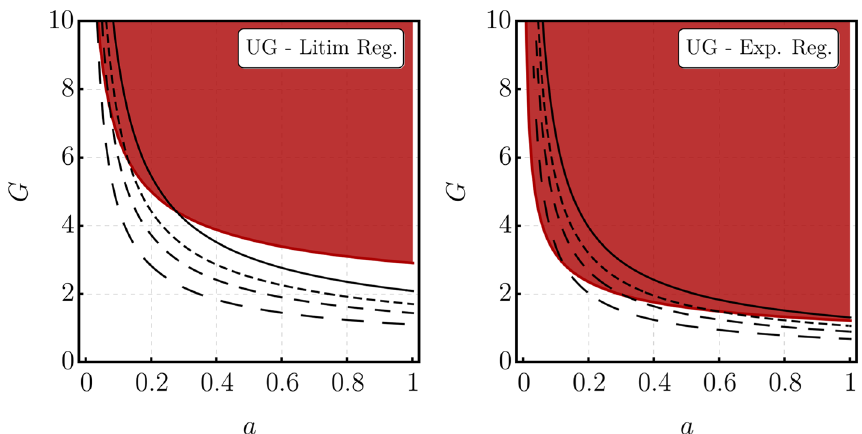
in the standard gravity setting,